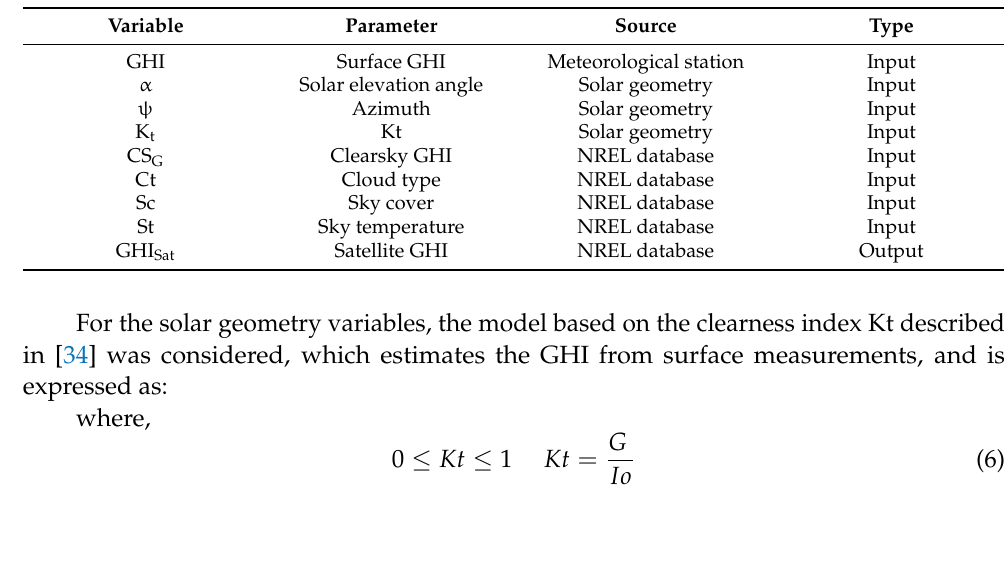
Table 3. Model predictors